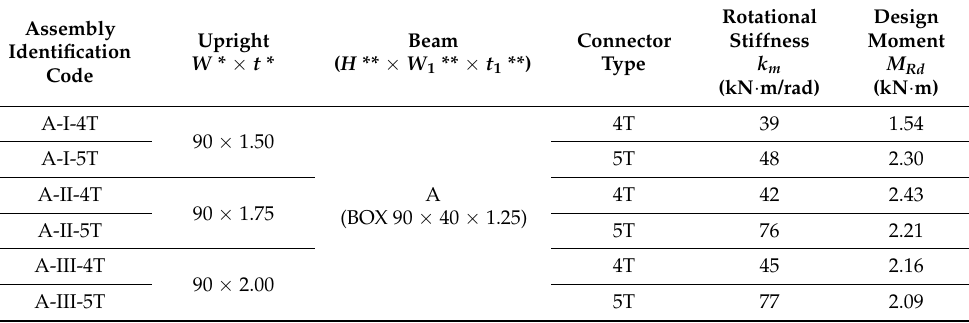
Table 2. Characteristics of the upright-connector-beam assemblies involved in analysis of the loose- ness effect on beam’s deflection and bending moment developed, adapted from ref.